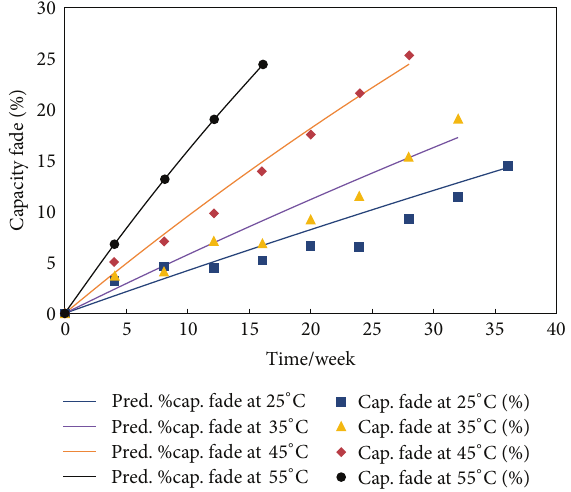
Figure 6: Percentage capacity loss versus time for Yardney cell at − 20 ∘ C, 10 ∘ C, 23 ∘ C, and 40 ∘ C.